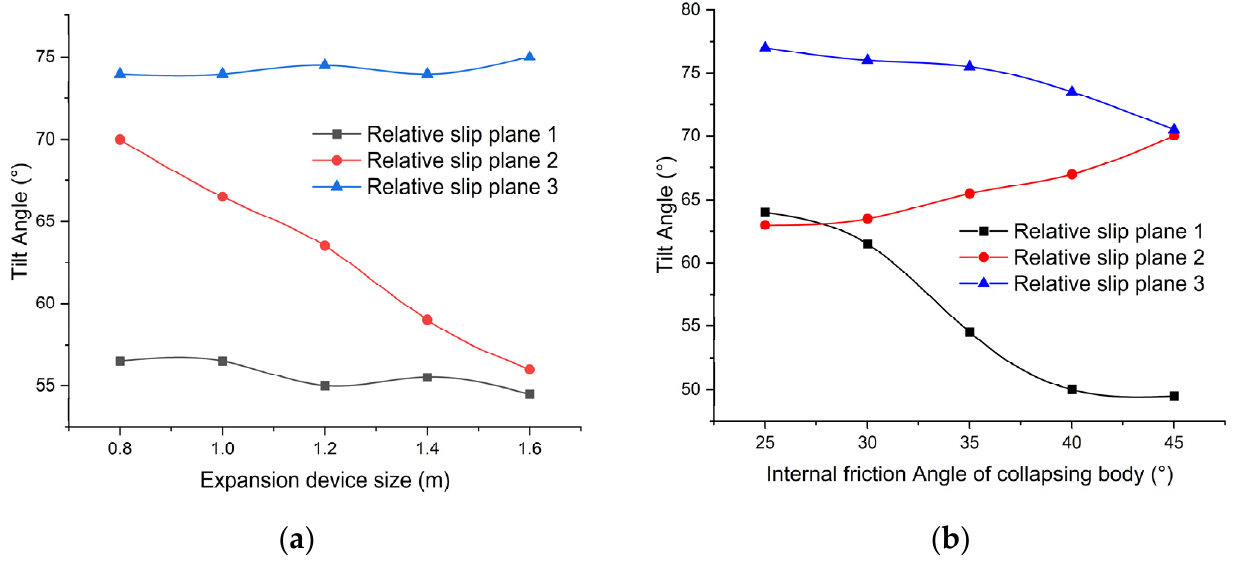
Figure 8. Variation curve of dip angle for the slip plane: ( a ) the dip angle of the slip plane with different expansion sizes when the internal friction angle is 37.5°; ( b ) the dip angle of the slip plane with different internal friction angles when the expansion size is 1.2 m.